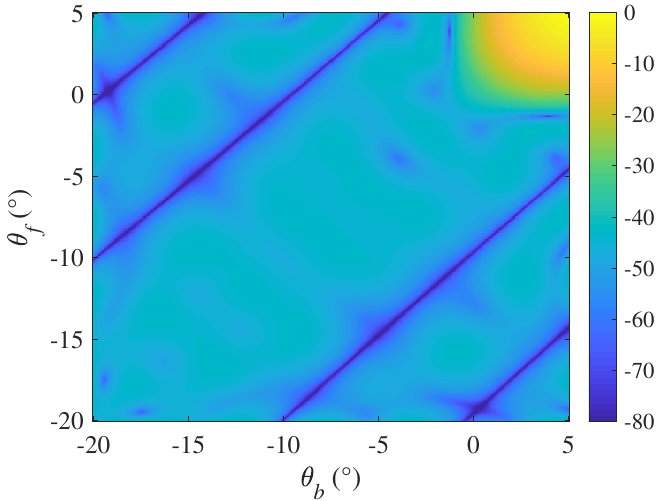
Figure 2. Magnitude response of the designed matrix spatial filter ( θ b and θ f represent the backward multipath angle and forward multipath angle